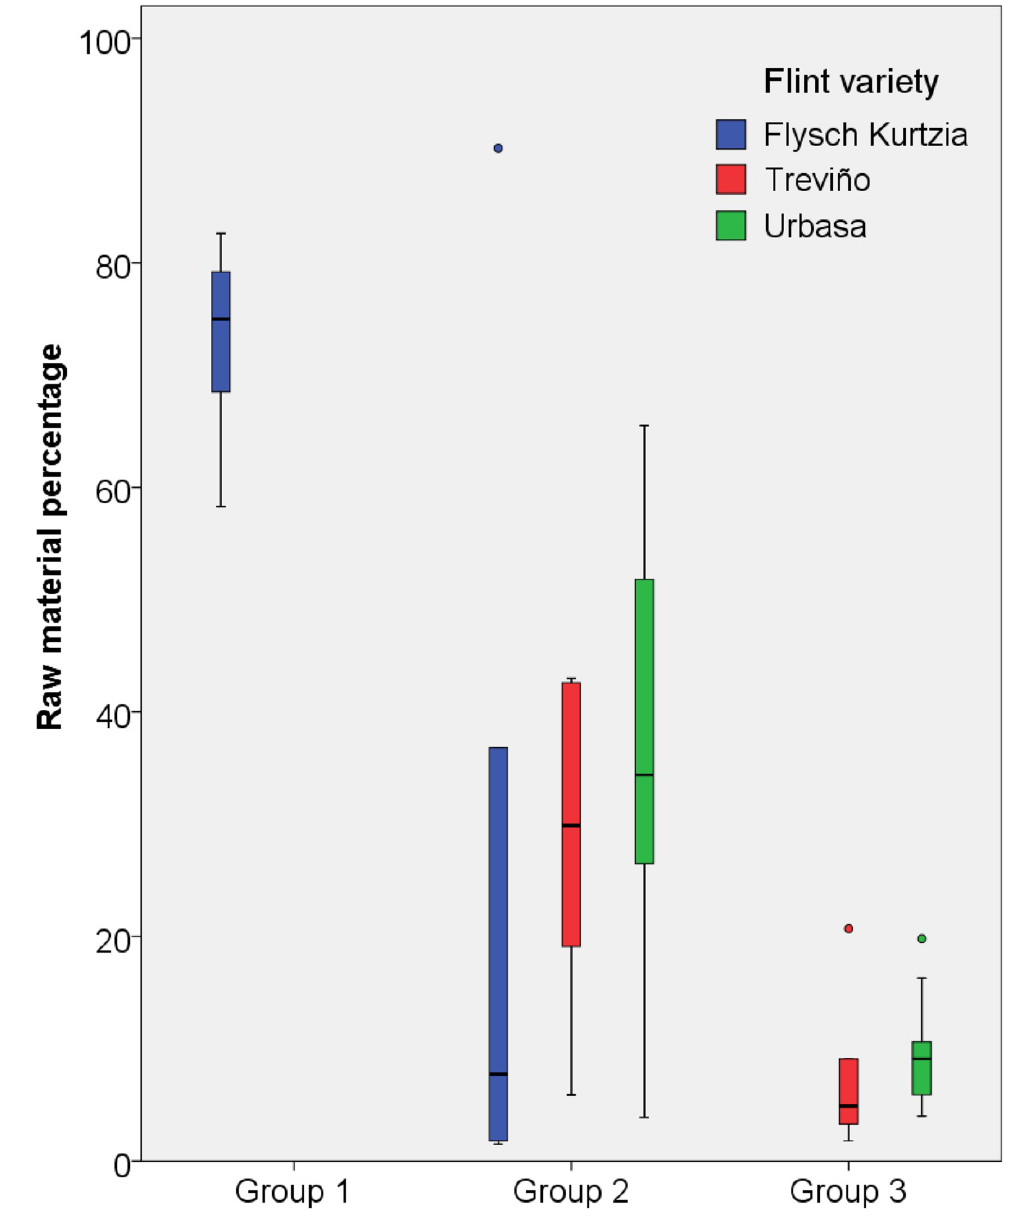
Figure 10. Boxplot which compares the variability of raw material percentages of each flint variety within each group proposed, using Cost